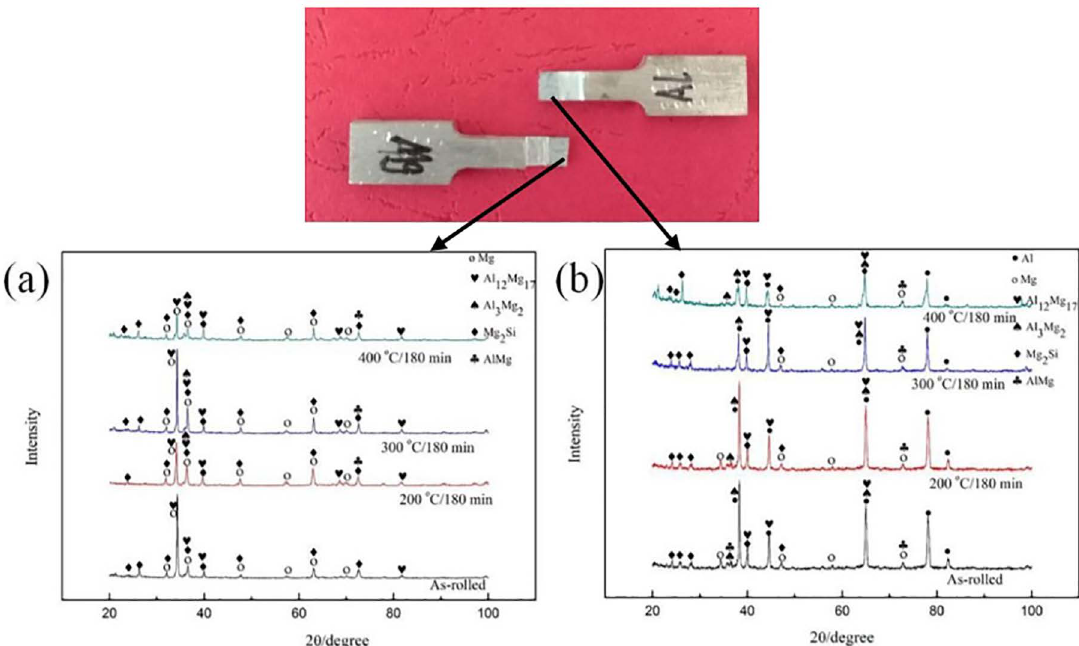
Figure 14. XRD patterns of the shear fractures on (a) the side-nearest the AZ31B and (b) the side nearest the